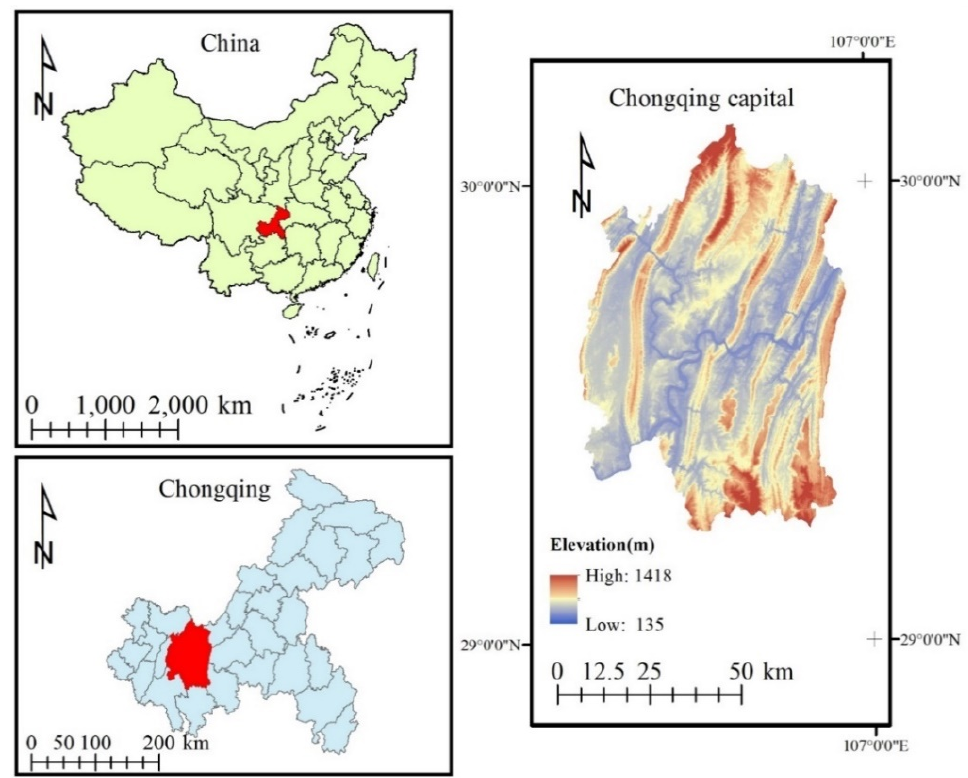
Figure 1. Location of Chongqing capital, China.